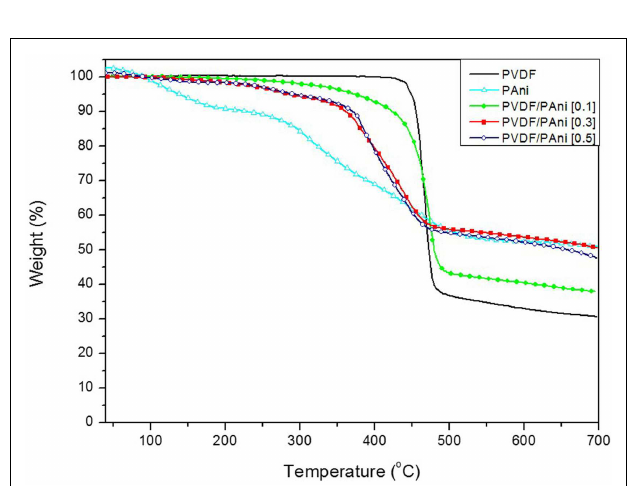
FIGURE 4 | Representative stress–strain curves of (A) electrospun PVDF mats, (B) PVDF/PANI [0.1], (C) PVDF/PANI [0.3], and (D) PVDF/PANI [0.5] .